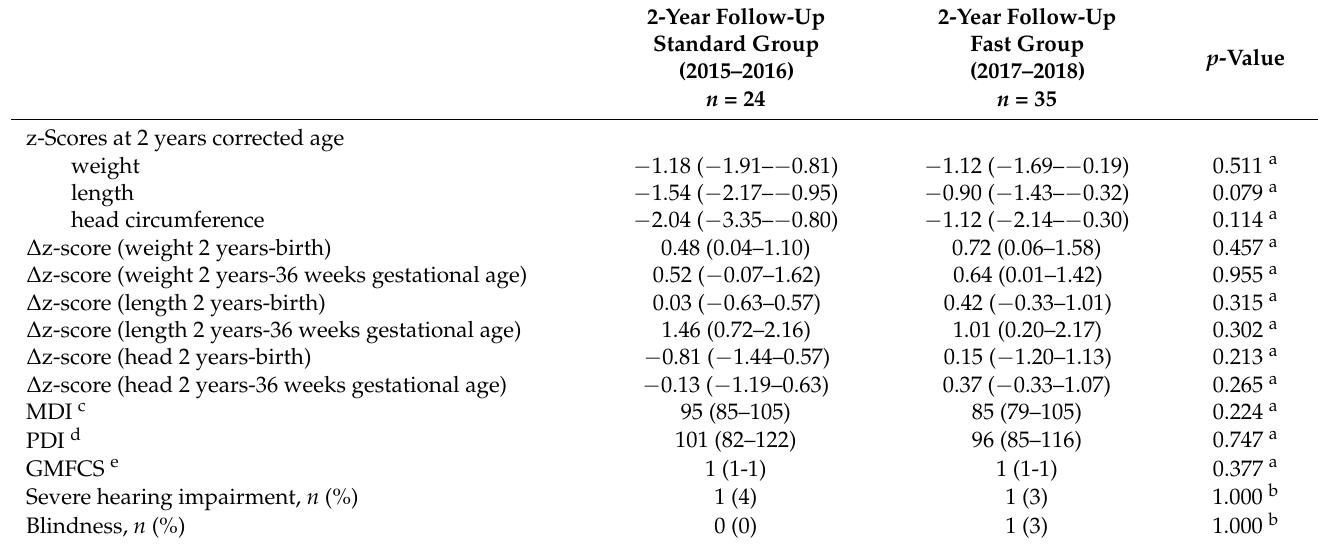
Table 5. 2-year somatic and psychomotor outcome variables in the study collective—SGA